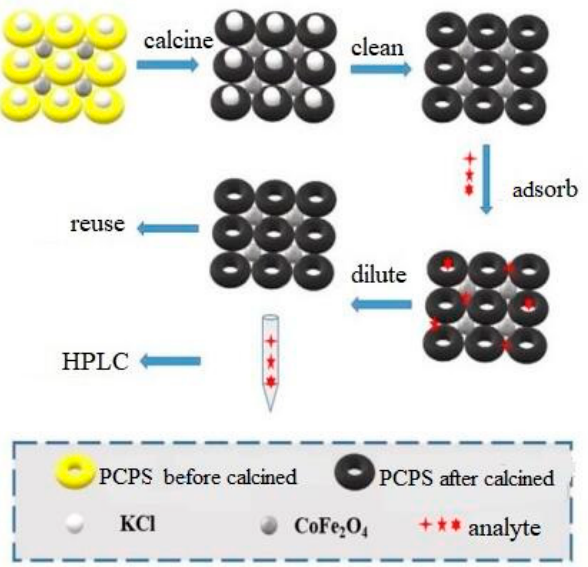
Figure 1. The schematic diagram of material synthesis and MSPE.